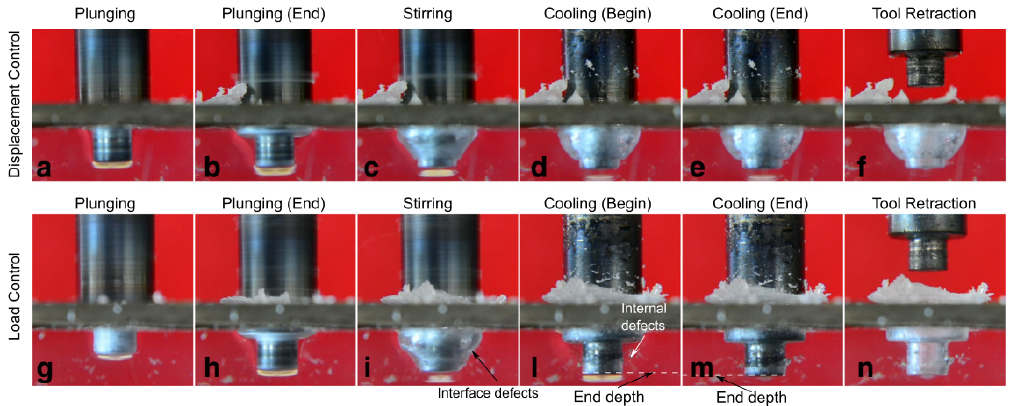
Figure 37. Effect of load control during cooling phase [74]. Sequence of processing phases under ( a – f ) displacement control and ( g – n ) load control.